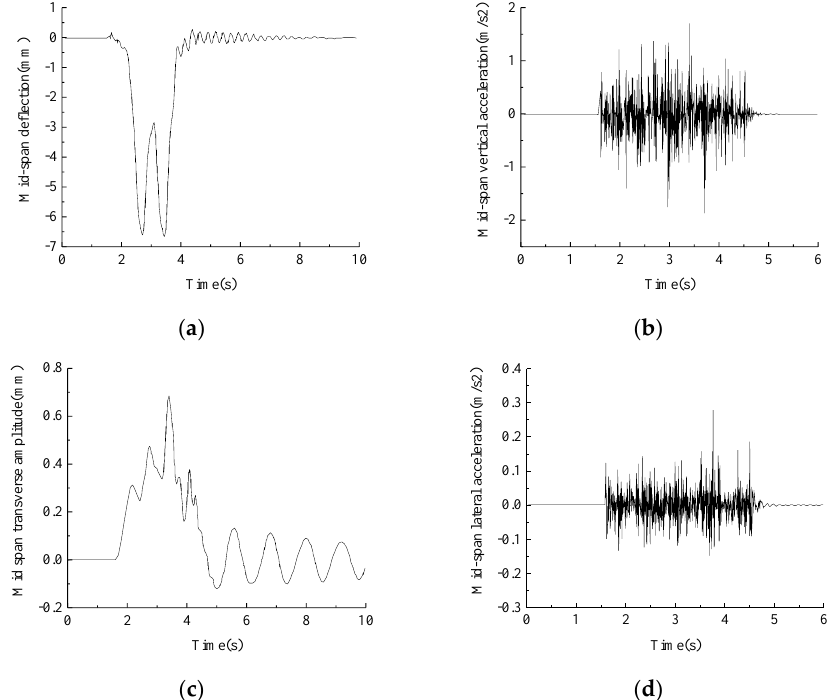
Figure 19. Mid − span vibration response of structure with damping ratio of 0.05: ( a ) Mid − span deflection (mm). ( b ) Mid − span vertical acceleration (m/s 2 ). ( c ) Mid − span transverse amplitude (mm). ( d ) Mid − span lateral acceleration (m/s 2